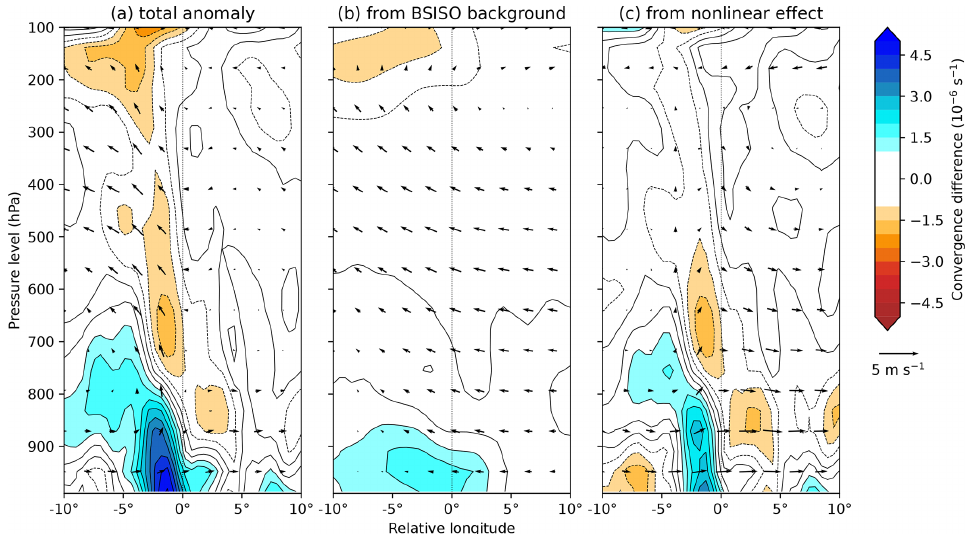
Figure 15. Zonal-vertical cross-sections of anomalous system-centred convergence and winds (parallel to the plane, i.e. u and w components, with w exaggerated by a factor of 200, approximately in keeping with the figure aspect ratio) for LPSs in BSISO phase 5, compared with the all-LPS mean. The total anomaly is given in (a) , the contribution from the BSISO alone is given in (b) , and the contribution from the interaction between the BSISO and LPSs is given in (c) . Computed for monsoon LPSs north of 15 ◦